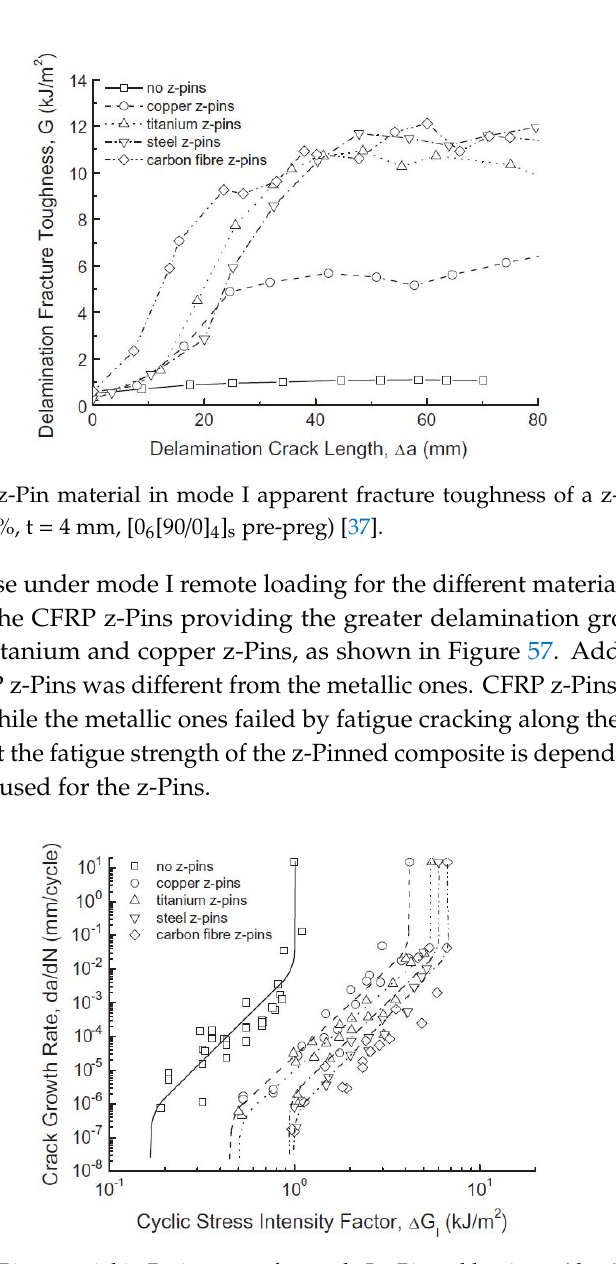
Figure 57. E ff ect of z-Pin material in Paris curves for mode I z-Pinned laminate (d = 0.51 mm, 2.0 vol%, t = 4 mm, [0 6 [90 / 0] 4 ] s pre-preg)